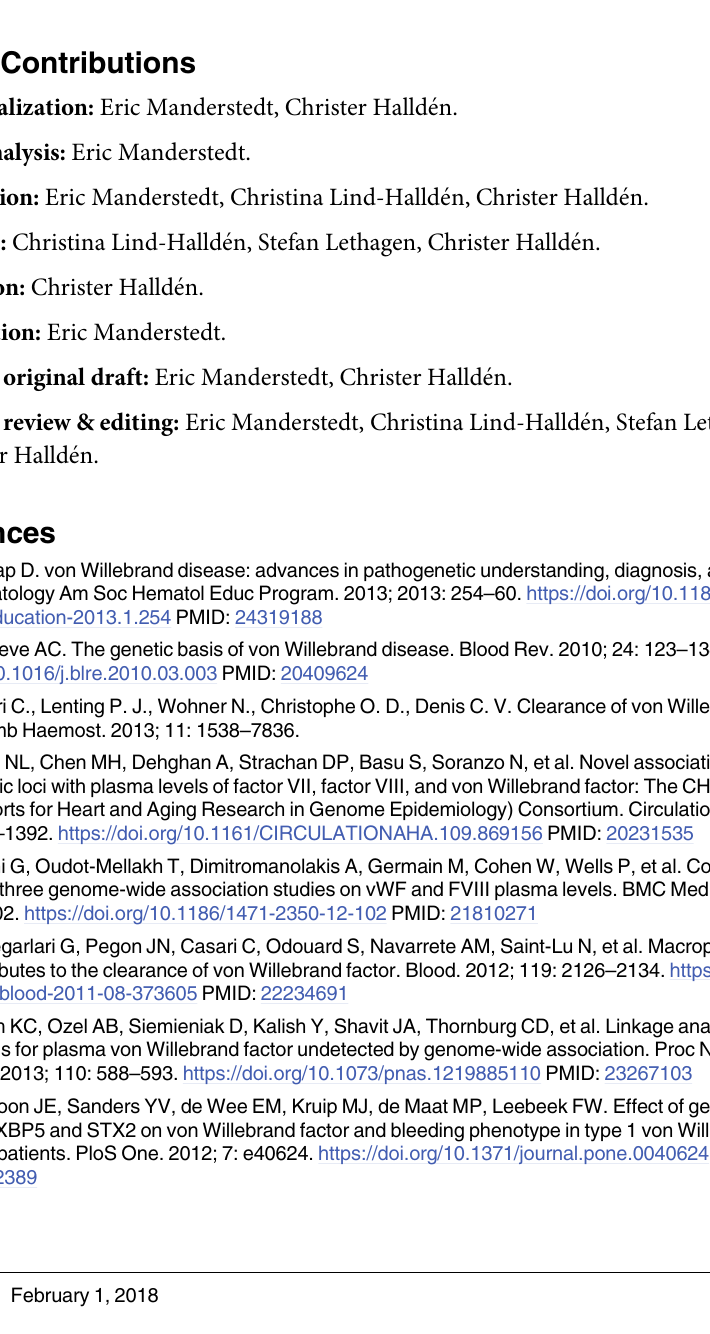
S1 Table. Primers for CLEC4M . S2 Table. Genetic variants found in CLEC4M per individual. S3 Table. MutationTaster predictions for SNVs found in CLEC4M